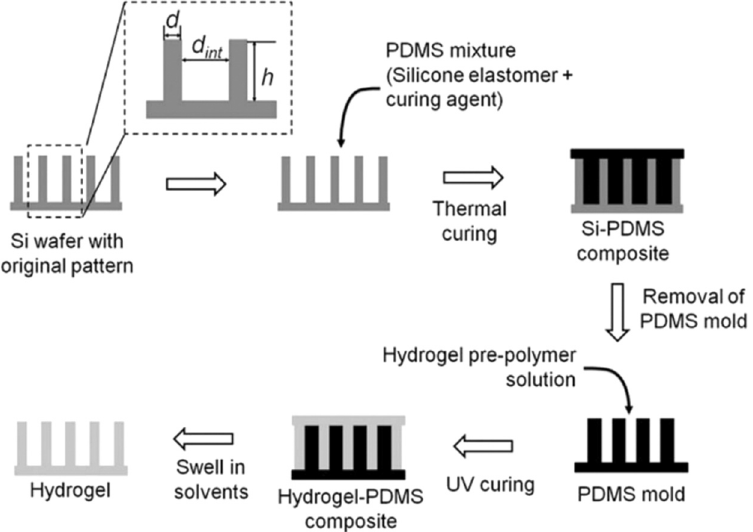
Figure 9: Soft lithography uses elastomeric stamp to replace hard stamp in traditional lithography to fabricate arrays of microstructures onto hydrogel surfaces ( reproduced from ref. [ 82 ])